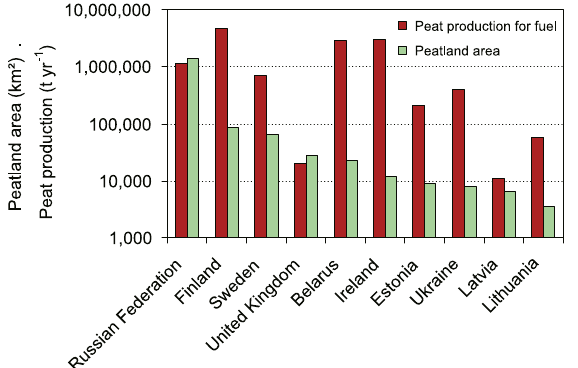
Fig. 2. Country-related pre-disturbance peatland areas compared to their annual peat extraction for energy purpose in Europe and the Russian Federation in 2008 (Data from World Energy Council